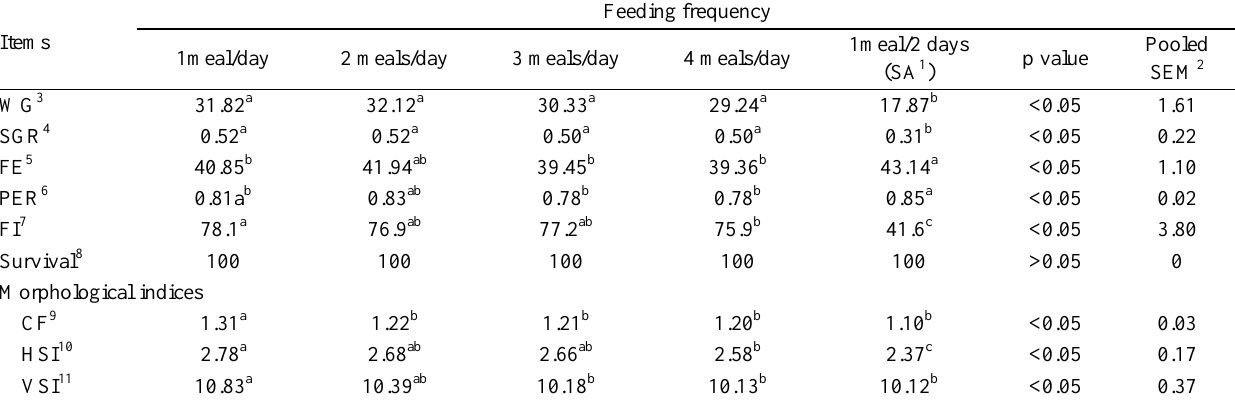
Table 3. Biological performance and morphological indices of 100 g Korean rockfish, reared at 19°C water temperature Items